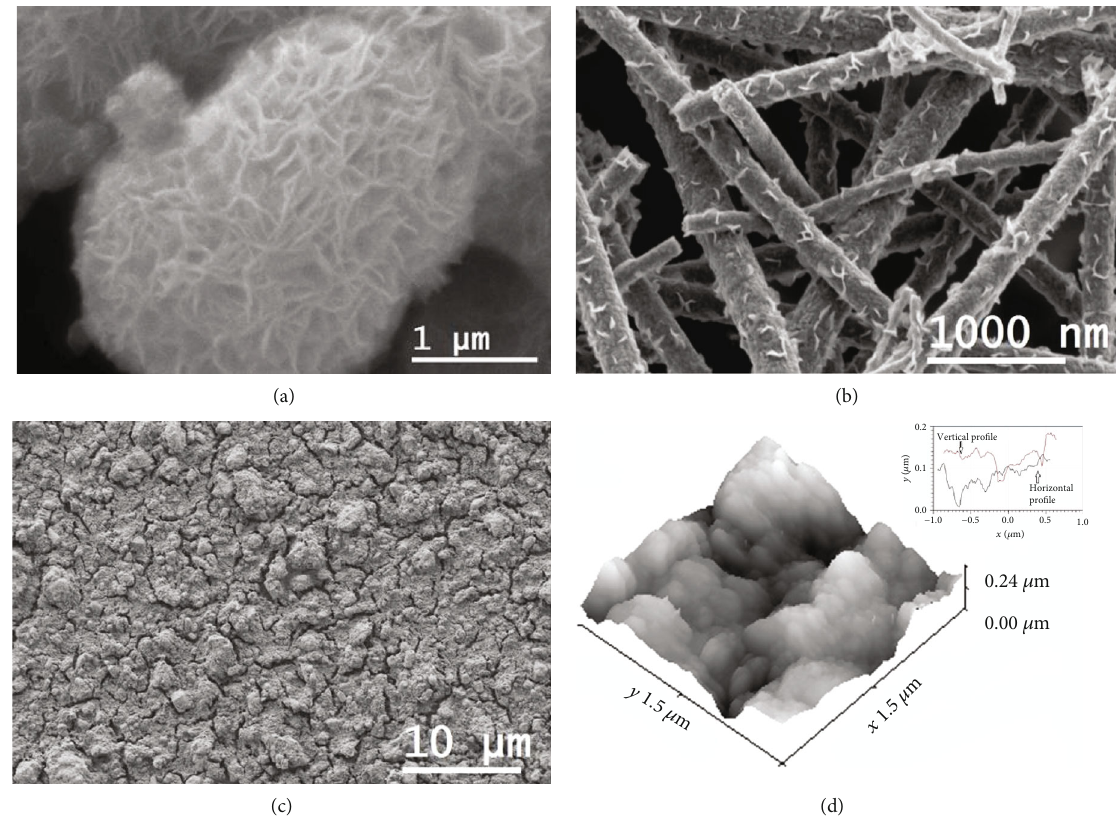
Figure 2: SEM images of the as-prepared (a) MoS mode AFM image of TMTF, inside them horizontal and vertical pro fi le graph of surface.